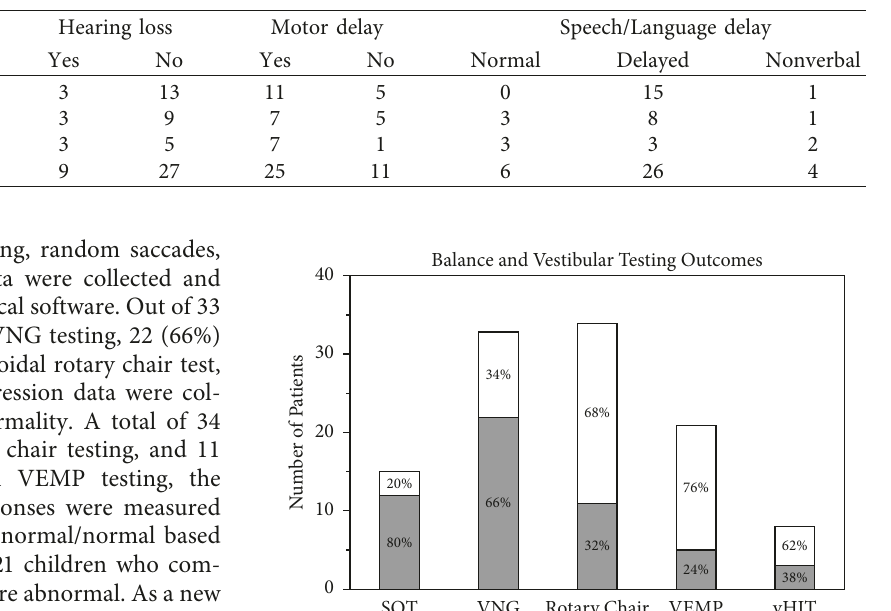
Table 1: Background characteristics by age group.